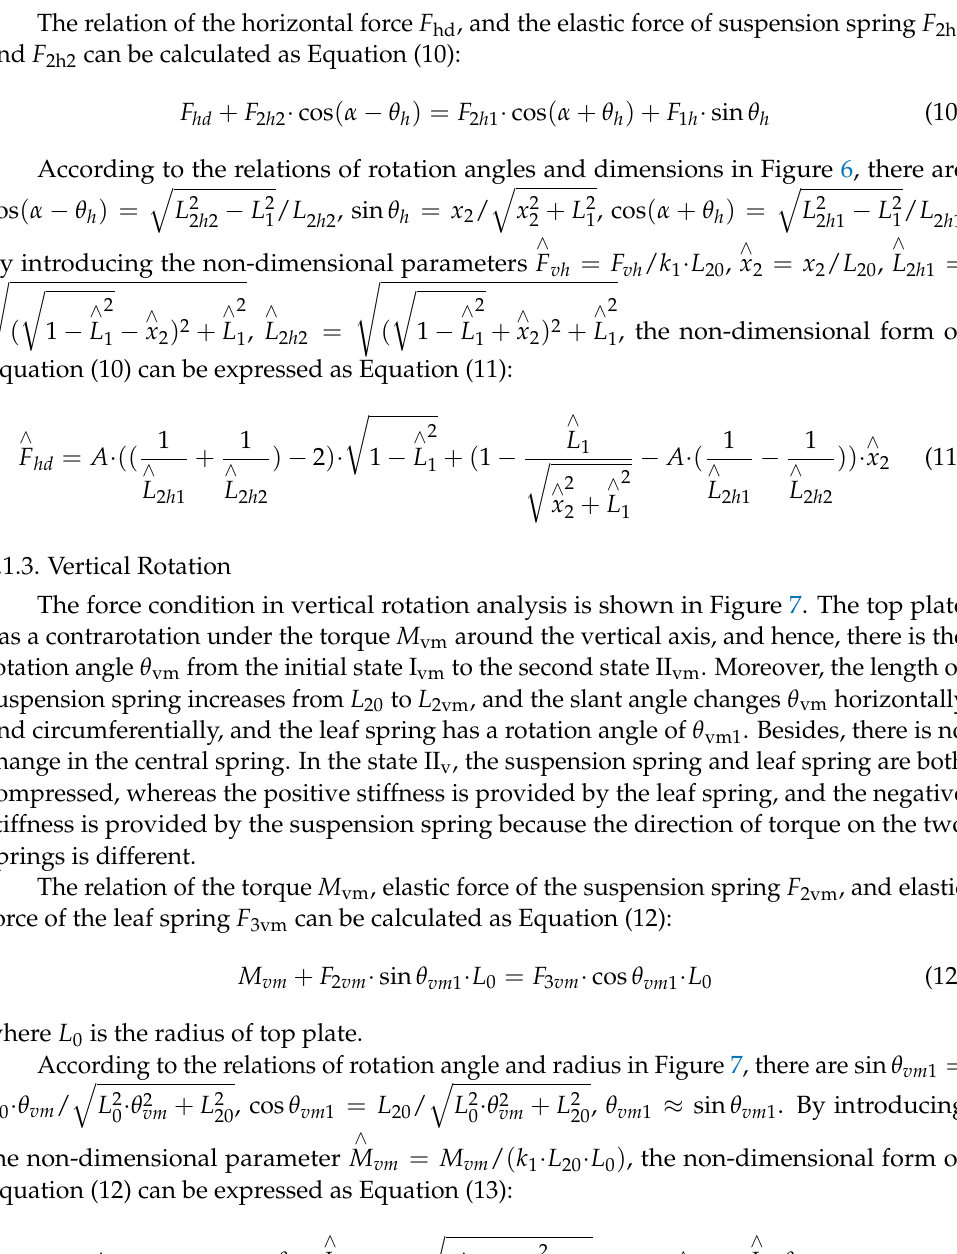
Figure 6. Schematic diagram of horizontal